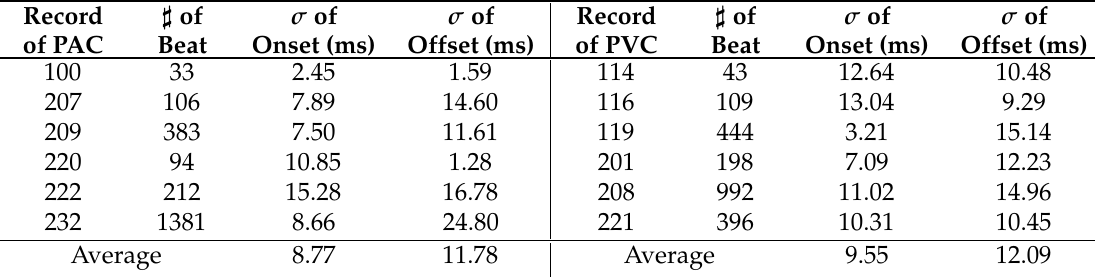
Table 2. Detailed results for stable data in Figure 12.